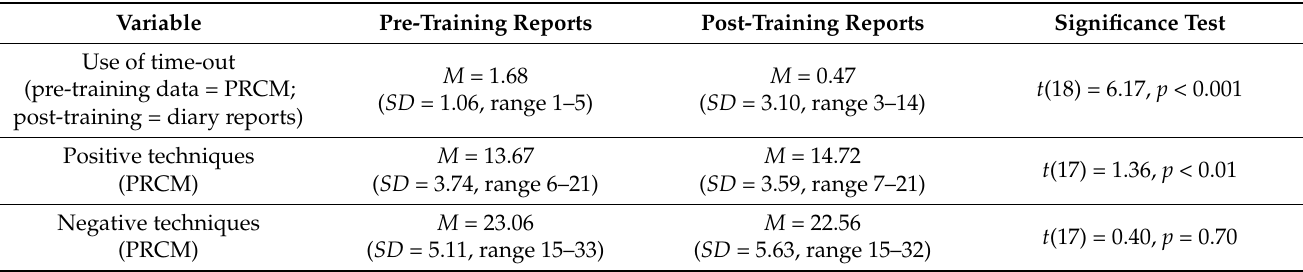
Table 1. Mothers’ reported behavior, pre- and